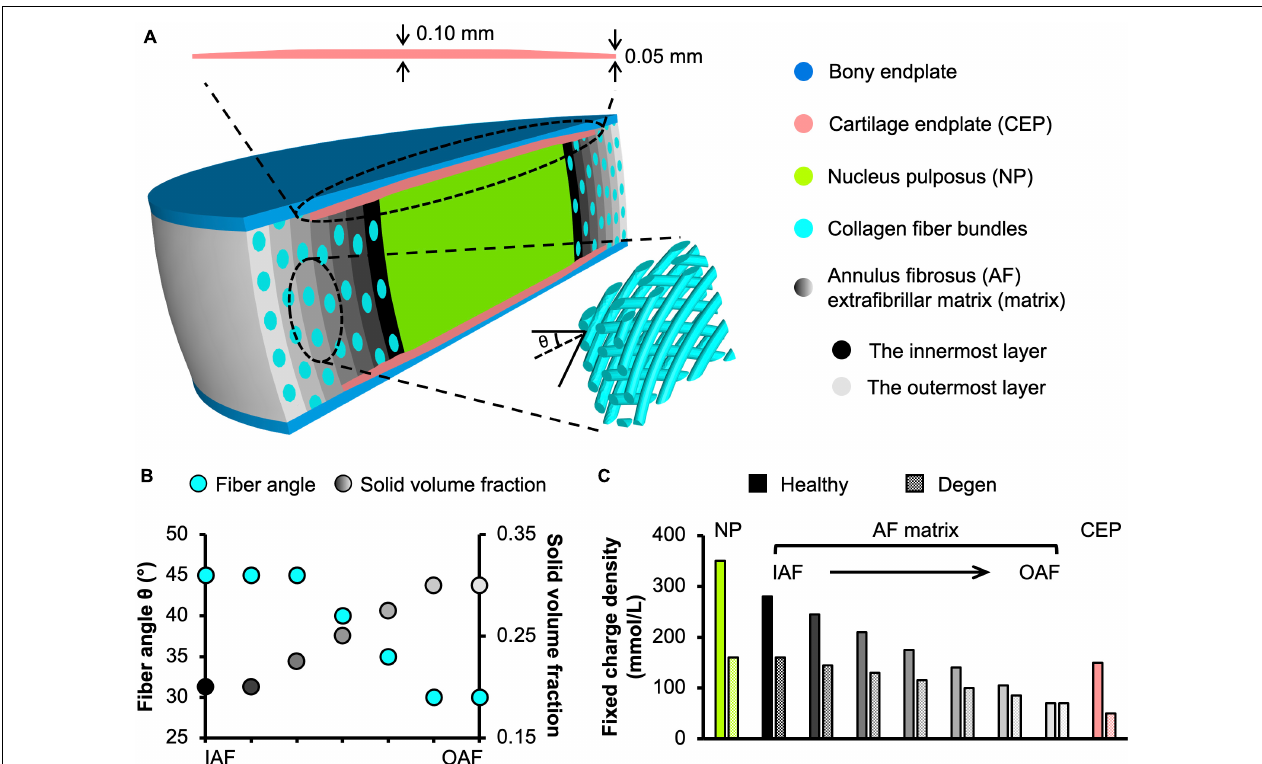
FIGURE 1 | (A) Schematic of the multiscale, structure-based bovine caudal disc motion segment model. The extrafibrillar matrix and collagen fibers of the annulus fibrosus (AF) were modeled as distinct materials occupying separate volumes. Insets present the cartilage endplate geometry (top) and the angle-ply fiber structure (bottom right). (B) AF fiber angle and solid volume fraction from the inner AF (IAF) to the outer AF (OAF). (C) Fixed charge density distribution in healthy and degenerated (Degen) disc models.